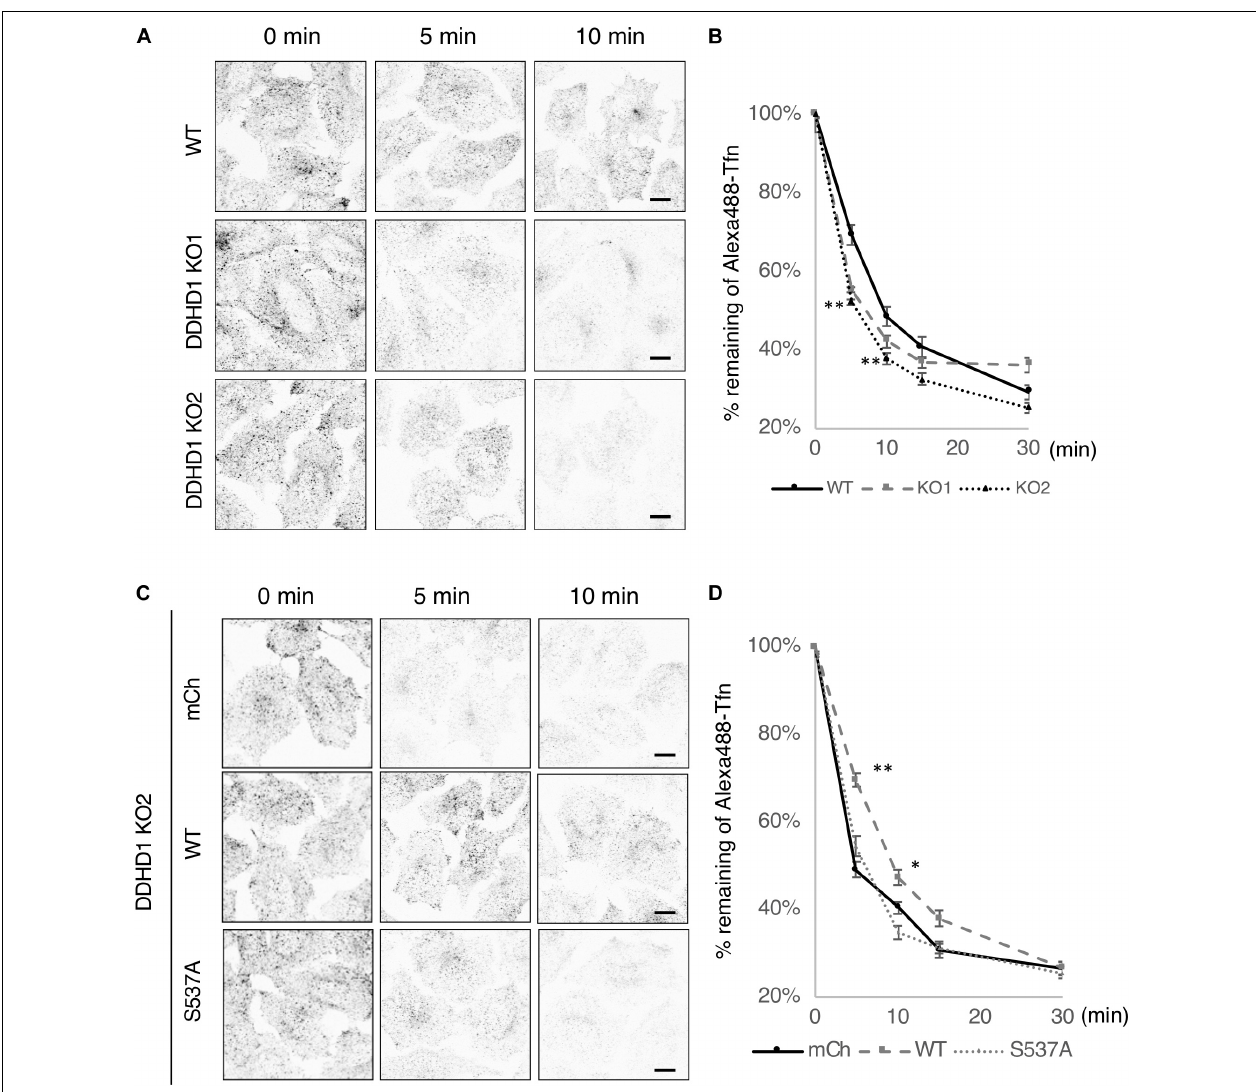
FIGURE 4 | Effects of DDHD1 activity on Tfn recycling in HeLa cells. (A,C) Wild-type or DDHD1 KO HeLa cells (A) or DDHD1 KO HeLa cells expressing mCherry, mCherry-DDHD1, or mCherry-DDHD1 S537A (C) were subjected to Alexa488-Tfn recycling assay for the indicated times as described under Experimental Procedures. Scale bars, 10 µ m. (B,D) the percentages of remaining Alexa488-Tfn signals compared to the fluorescent signals at 0 min are shown in the graph. Values are expressed as means for three independent experiments ± S.D. * p < 0.05; ** p < 0.01; (Tukey test).